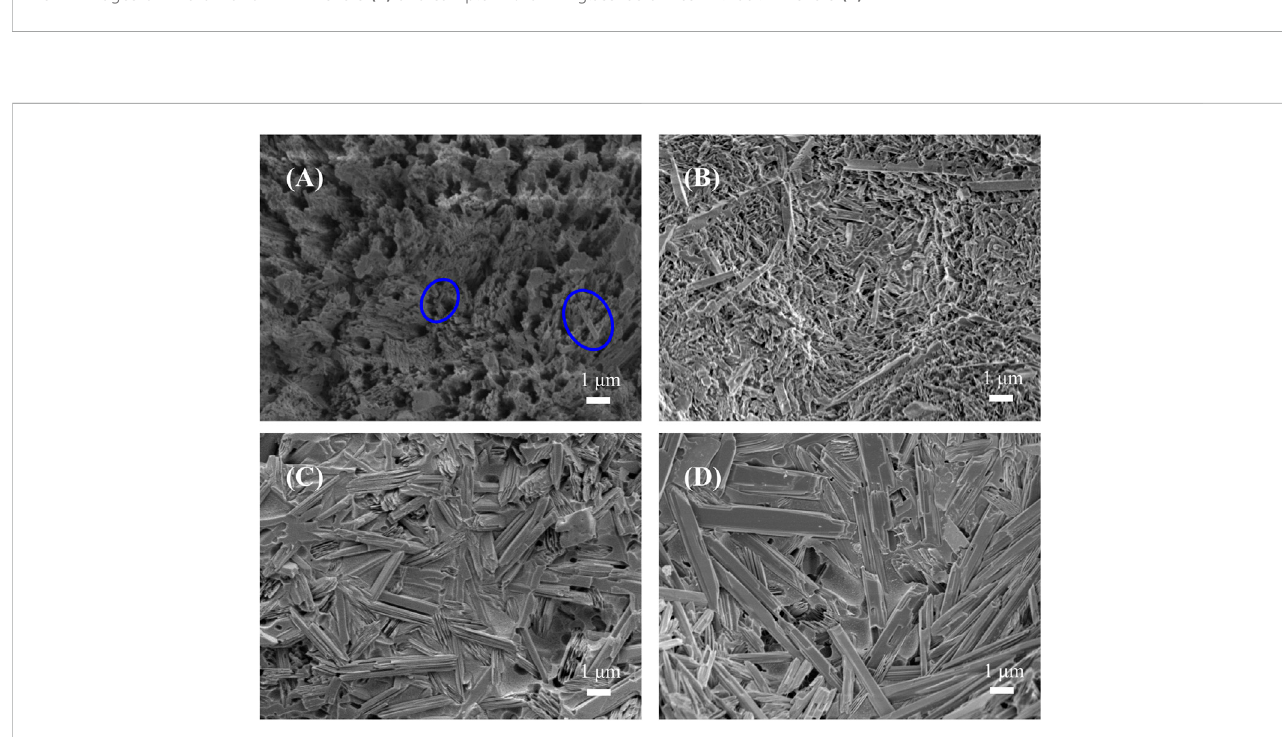
FIGURE 5 SEM images of LD glass-ceramics treated by different temperature: (A) W1; (B) W2; (C) W3; (D)